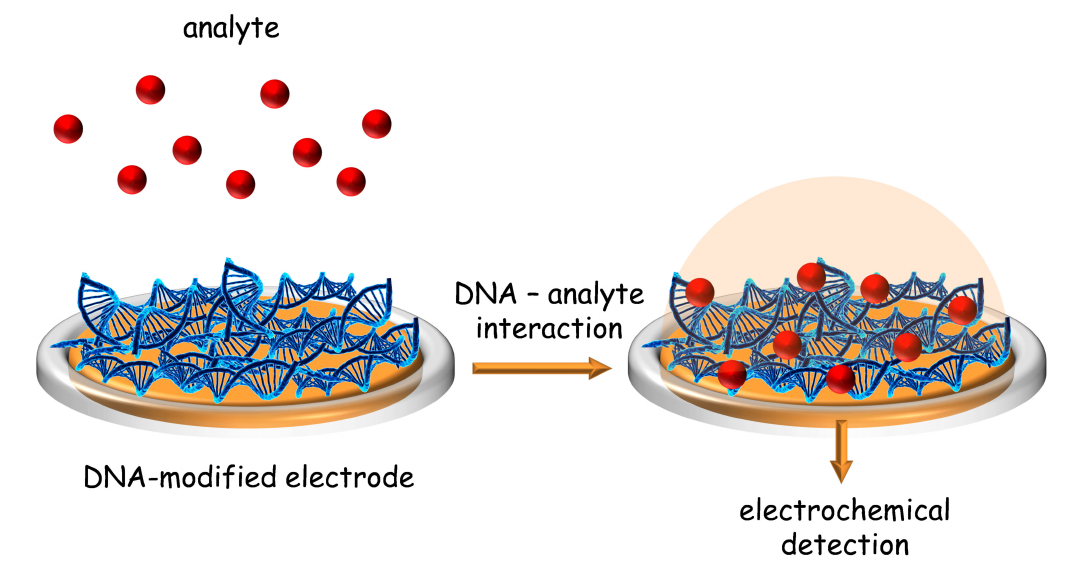
Scheme 2. Schematic representation of DNA electrochemical biosensor design and operation. A DNA layer is immobilized at the electrode surface and acts as a recognition element, interacting with the target analyte; the DNA oxidation peaks before and after the interaction with the analyte are recorded and